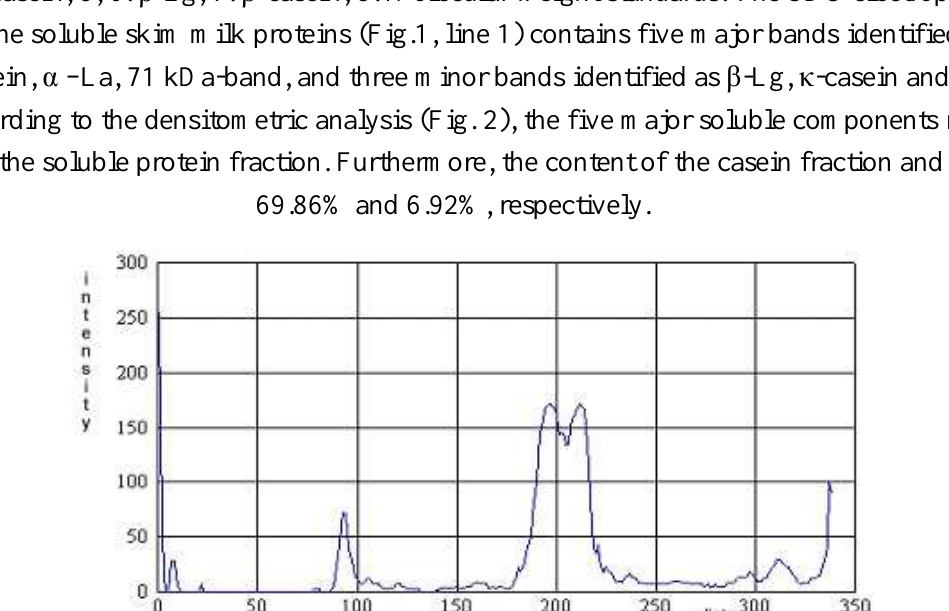
Figure 2 . The densitometric analysis of the soluble proteins (without 2-mercaptoethanol) of the reconstituted skim